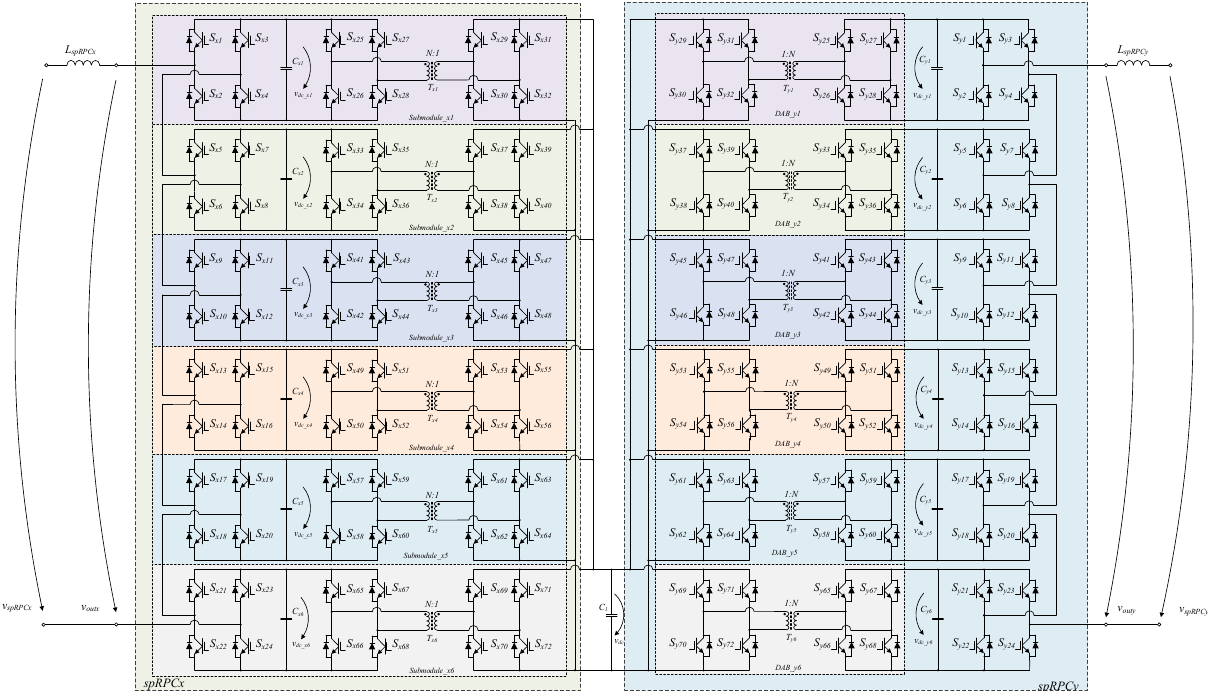
Figure 2. Electrical schematic of the proposed topology for the sp-RPC.